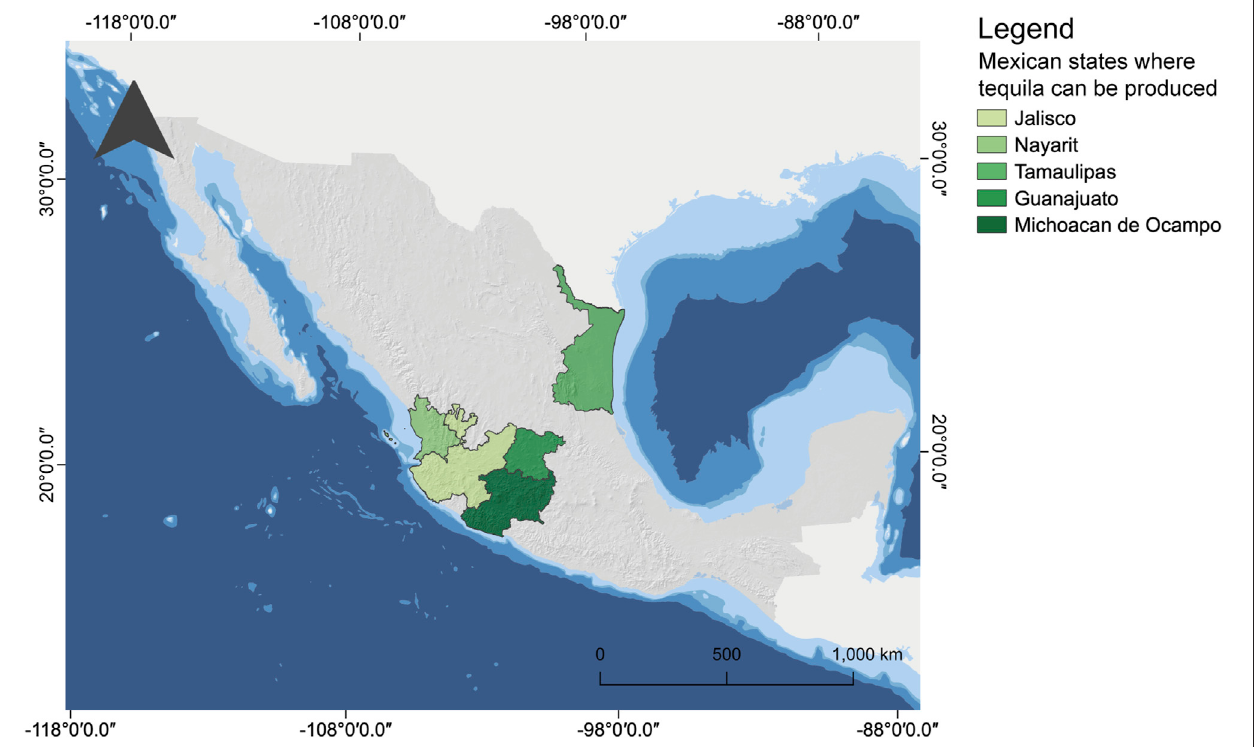
FIGURE 1 | Distribution of tequila-producing states in